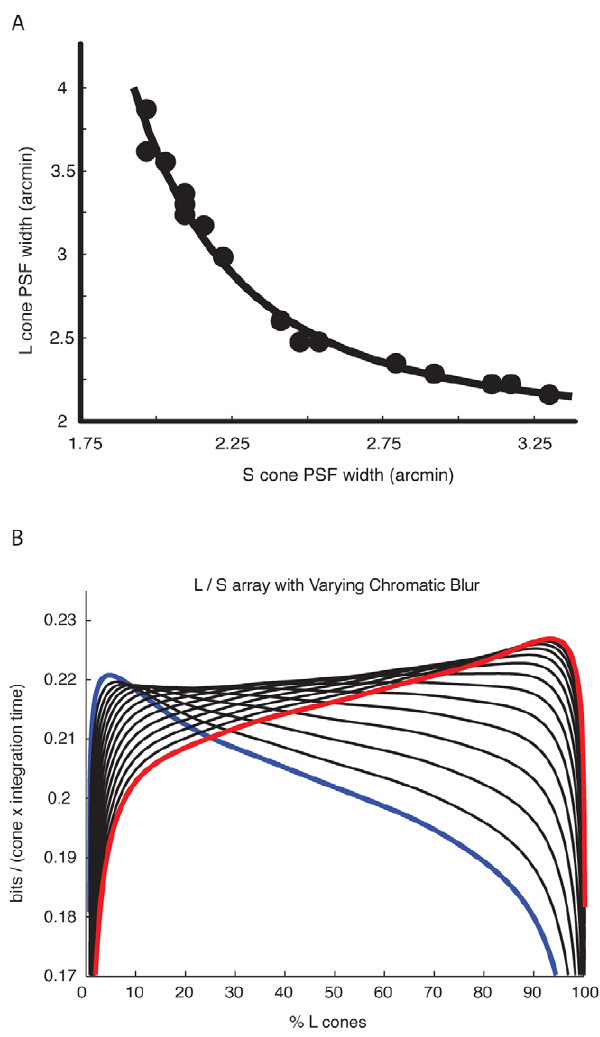
Figure 7. S channel vs. L channel chromatic aberration. (a) As the eye accommodates, the S cone and L cone PSFs trade off. The PSF can be decreased in width for one cone class at the cost of increasing its width for the other. Widths shown are one half of the radius that enclosed 90% of the PSF. (b) The LS information curve is shown for varying accommodation. When the lens focuses shorter wavelengths, the optimal mosaic favors S cones (blue line). When the lens focuses longer wavelengths, the optimal mosaic favors L cones (red line).